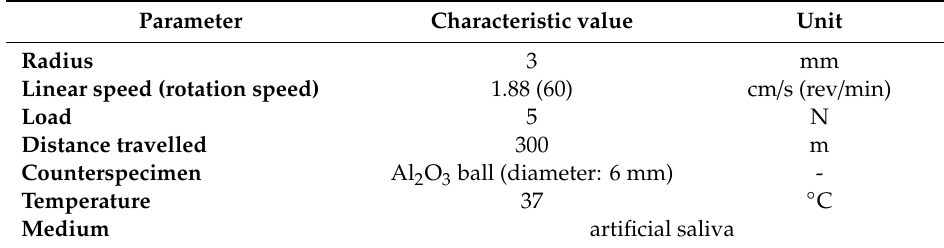
Table 2. Parameters of the sliding wear test.